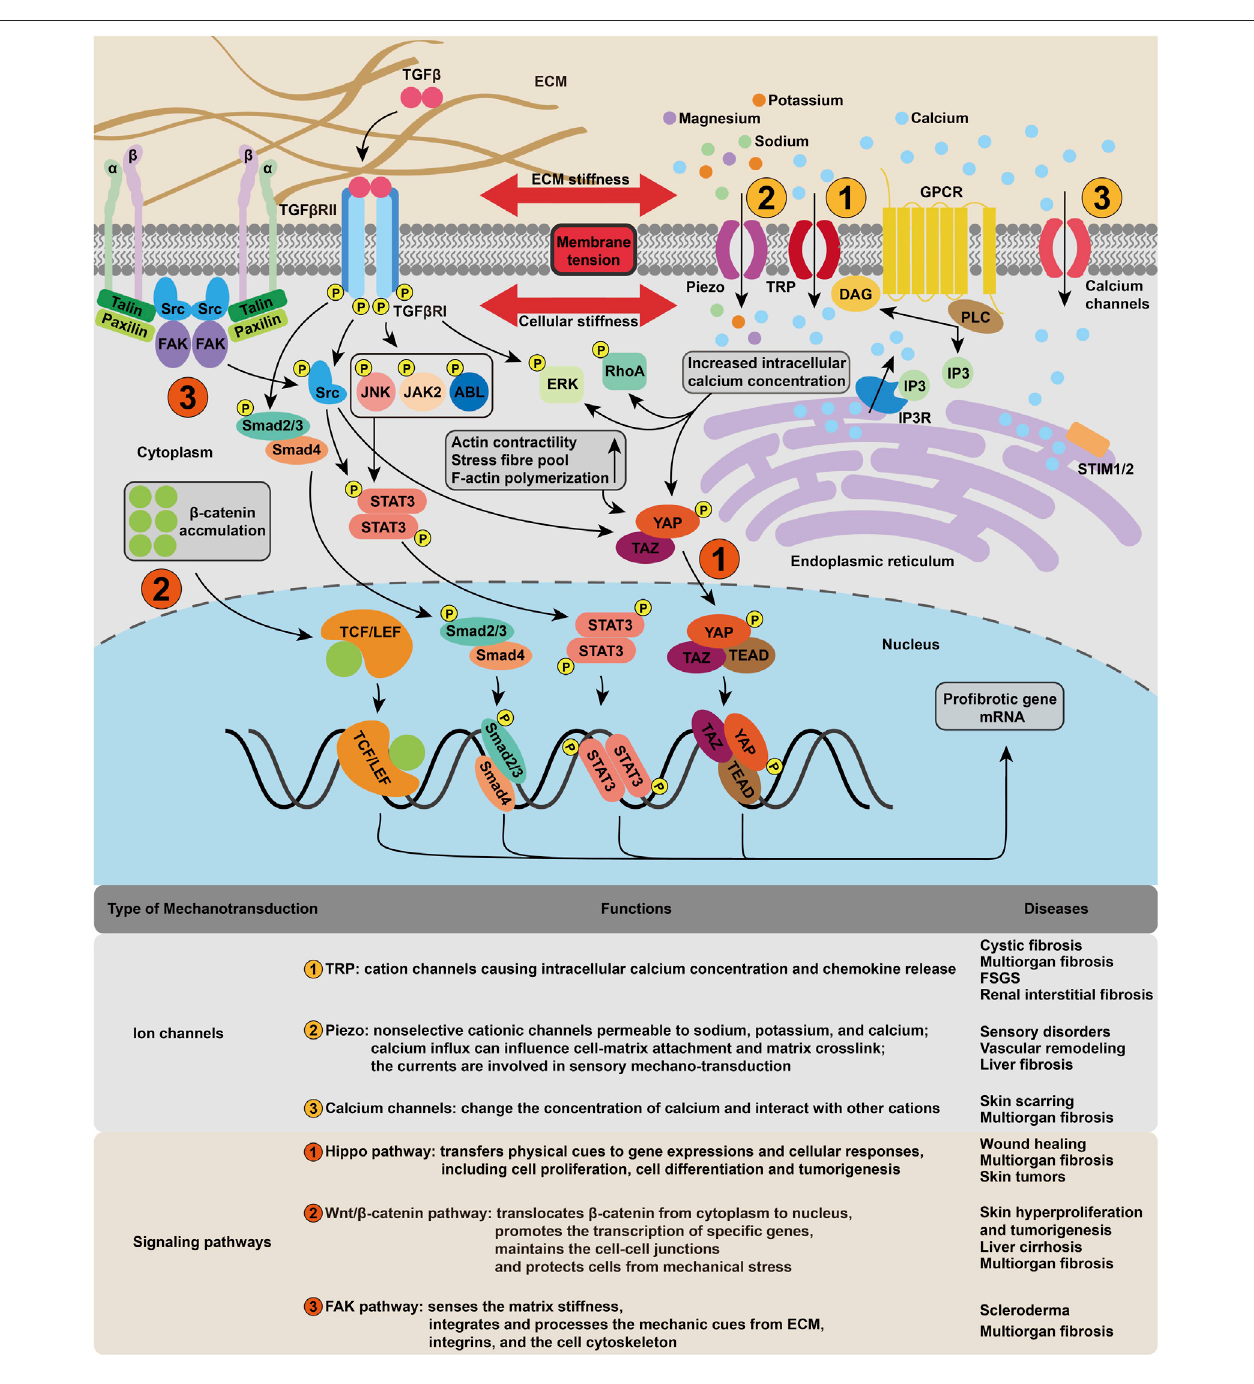
FIGURE2| Cellularmechanotransductionmechanismin fi brosis.Themembranetensionactivatesvariousmechanosensitiveionchannels,suchaspiezoandTRP, resultinginthechangeofintracellularionconcentration,whichinturnleadstotheupregulationofsignalingpathwaysincludingERK,RhoA.Thecytoskeletondeformation regulates fi brotic gene expression mainly through FAK, Hippo and Wnt/ β -catenin pathways.